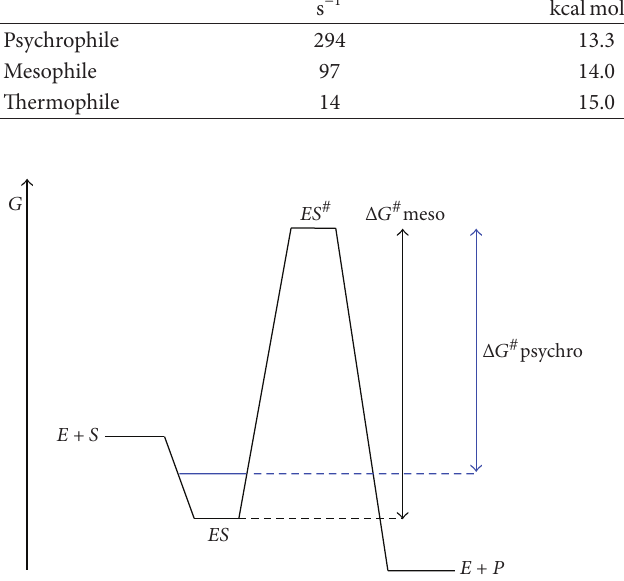
-amylases at 10 C. Adapted from [160]. ○ 𝛼𝛼